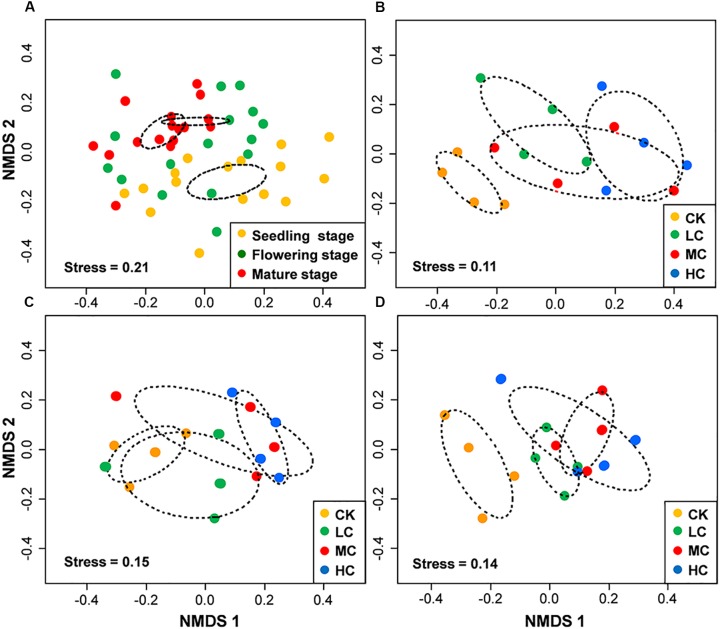
Non-metric multidimensional scaling (NMDS) of fungal community composition among growth stages (A), among treatments in seedling stage (B), flowering stage (C), and mature stage (D). Circles with dashed line in NMDS plot are 95% confidence ellipses. CK, control; LC, low level of compost addition; MC, moderate level of compost addition; HC, high level of compost addition.